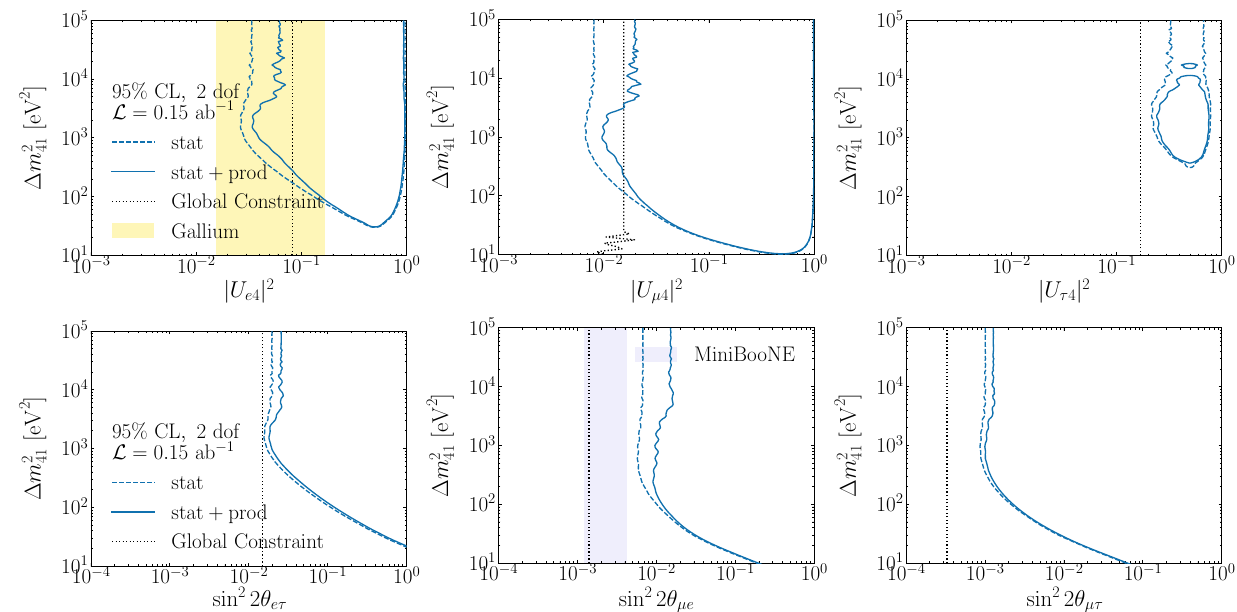
Fig. 22 The 95% CL regions of sterile neutrino parameters that will be excluded by FASER assuming different normalization uncertainties. The regions to the right of the black dotted lines are already excluded by previous experiments [146–148]. The yellow shaded region in the